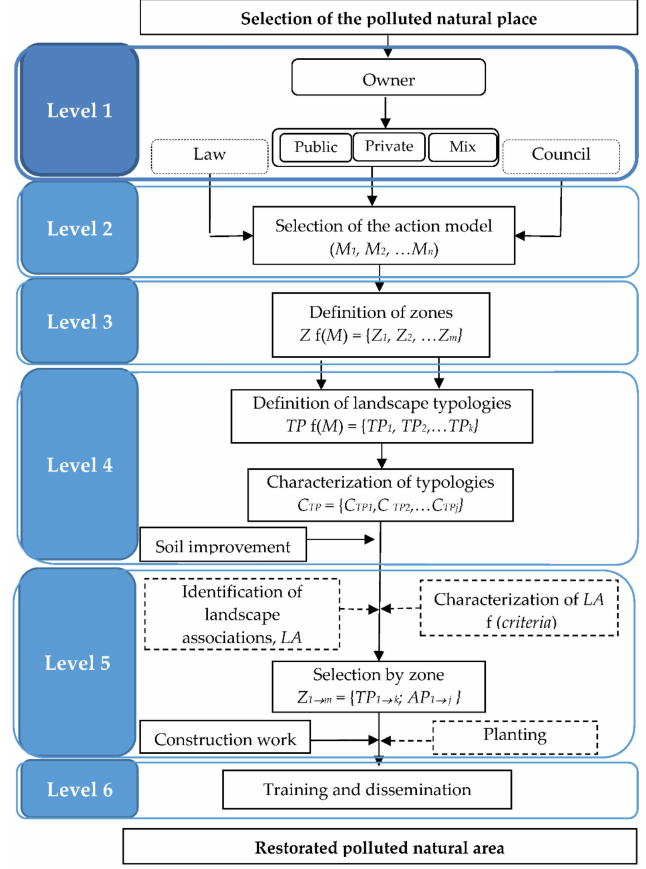
Figure 1. Outline of an action model for the rehabilitation of degraded natural areas when the pollution area is known. (—) actions related to plants. (M: action model; Z: zones depending of the model; C TP : Characterization of typologies; LA: landscape associations; Z 1 → m : selection of landscape associations for landscape